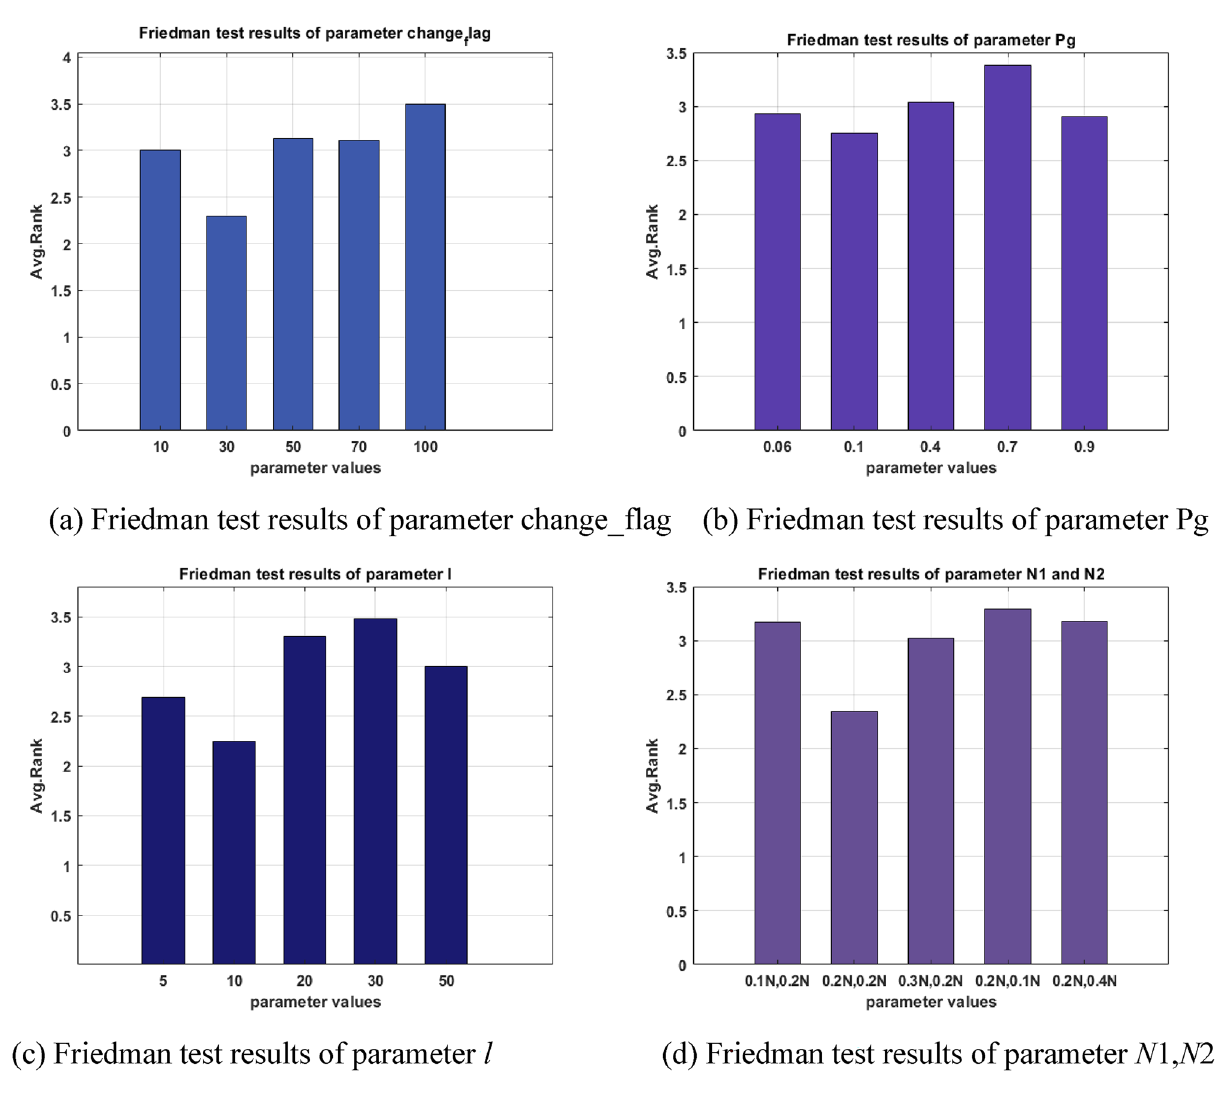
Figure 7. Results of the Friedman test for each